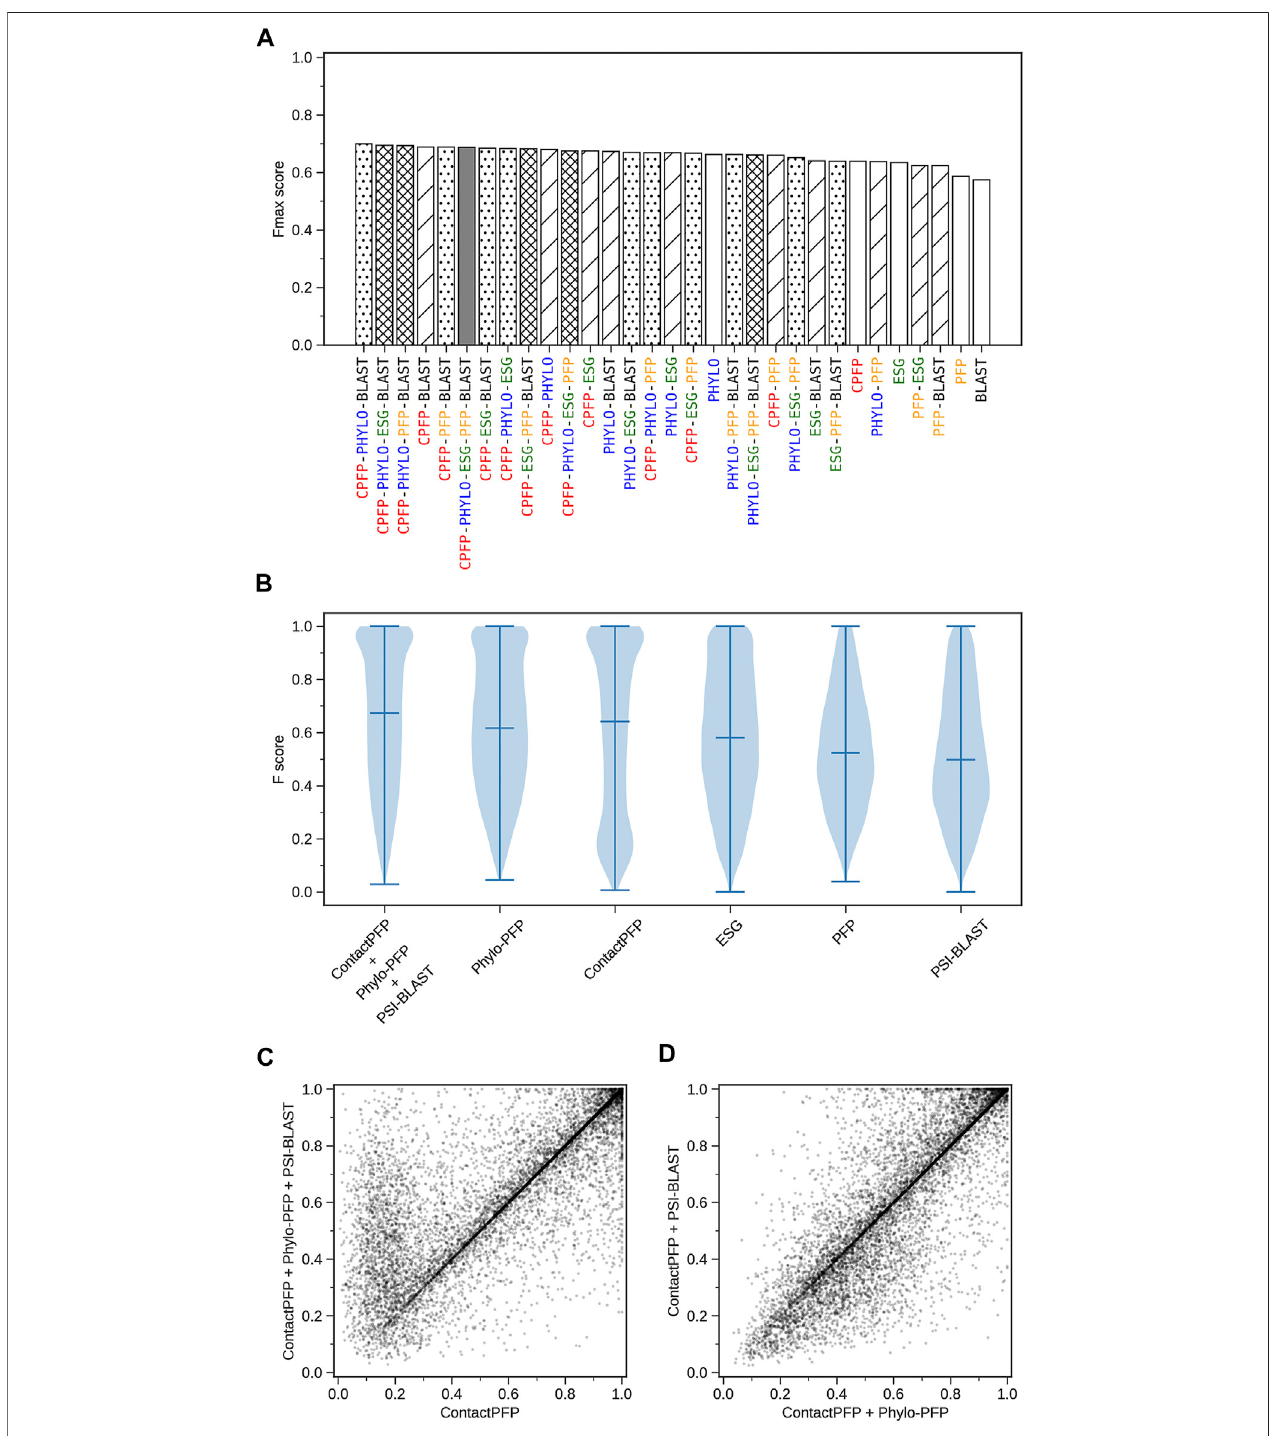
FIGURE8| ThepredictionperformanceofensemblemethodswithContactPFP. (A) TheaverageFmaxscoreofensemblemethodswithContactPFP.Resultsofall the combinations of 1 – 5 methods are shown. Patterns in the bar graphs show the number of methods combined. The bars are sorted by their Fmax scores. CPFP, ContactPFP; PHYLO, Phylo-PFP; BLAST, PSI-BLAST. (B) Fmax score distribution of the ensemble method with ContactPFP, Phylo-PFP, and PSI-BLAST, the combination with the highest Fmax score, and distributions of individual methods shown in violin plots. The three horizontal bars in a plot indicate the maximum, median, and minimumvalues. (C) Comparison ofFmax scoresofindividualtargetproteins bythebestensemblemethodand Phylo-PFP. Each pointrepresentsatarget protein in the benchmark dataset. (D) Comparison of Fmax scores of individual target proteins by the ContactPFP + PhyloPFP and ContactPFP + PSI-BLAST.